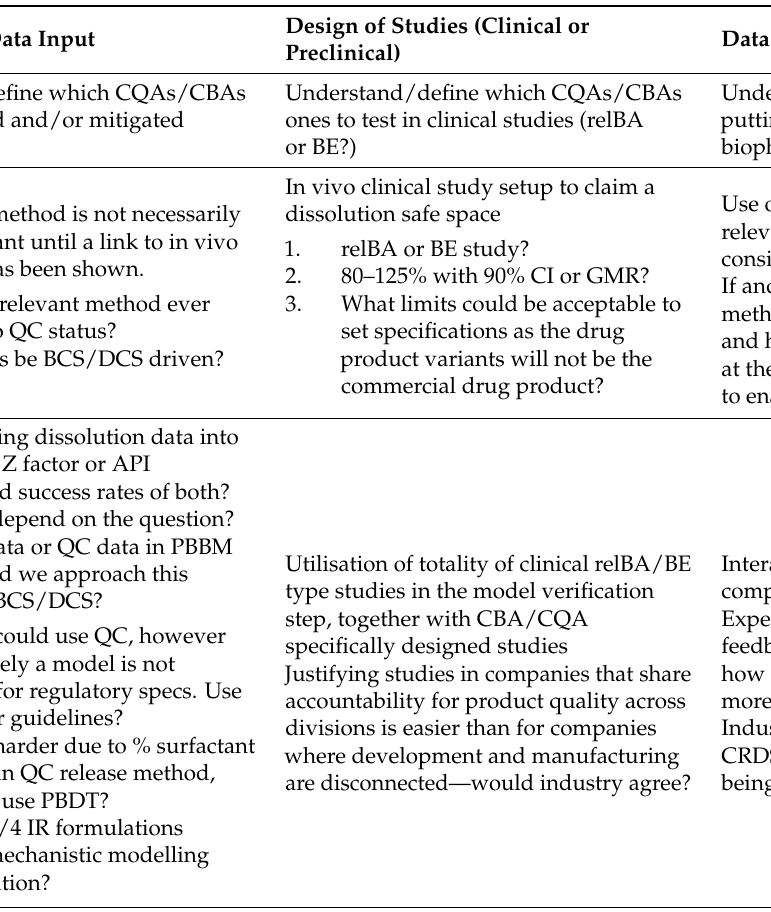
Table 1. Webinar Q&A Sessions: Major Discussion Topics and Resulting